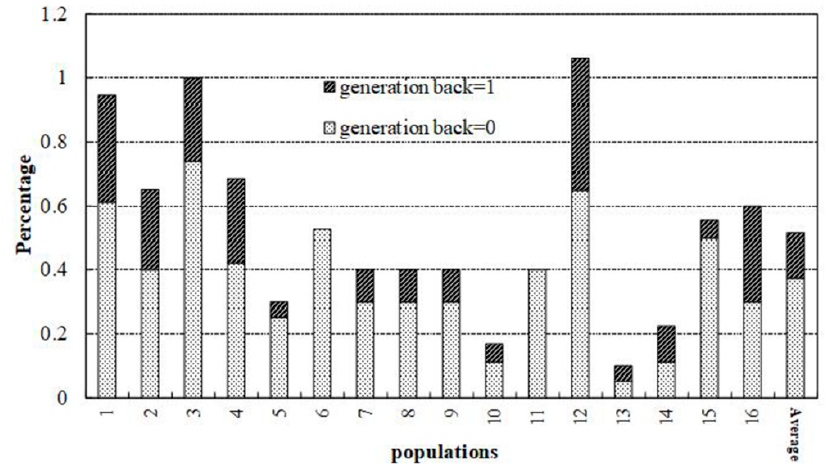
Figure 7. Immigrant ( G : Generation back; G = 0 and 1, single parent and itself) ratio for each population of C. dactylon in the last two generations.